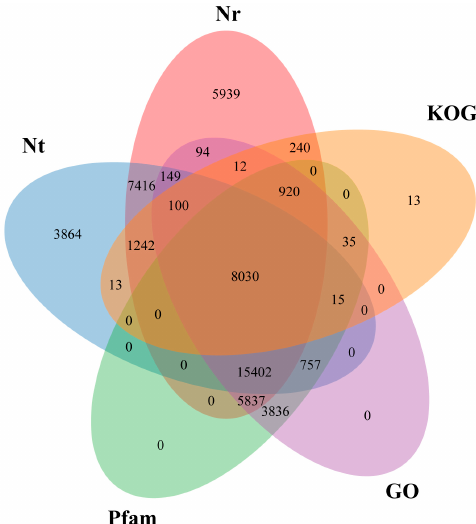
Figure 1. Venn diagram of annotation against the National Center for Biotechnology Information (NCBI) non-redundant (Nr), nucleotide sequences (Nt), Protein family (Pfam), Gene Ontology (GO) and euKaryotic Ortholog Groups (KOG) databases for the Pinus bungeana unigenes.